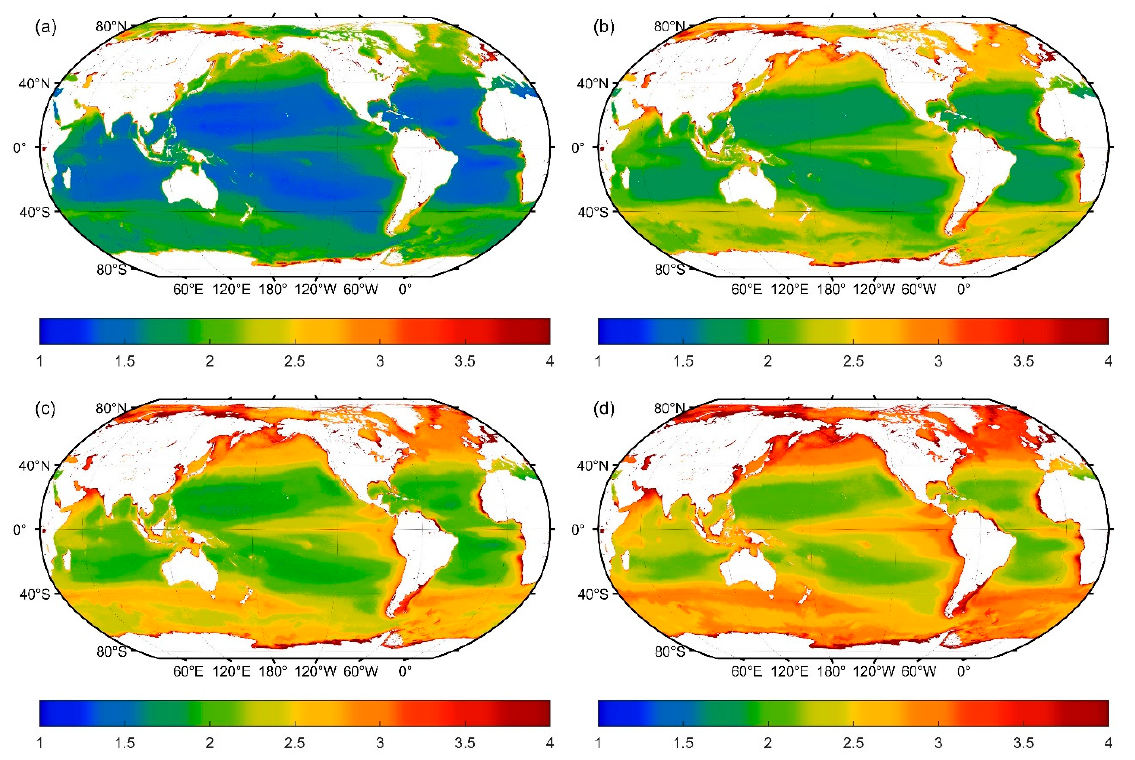
Figure 14. Global distribution of the number of optical depths at 490 nm to reach the corresponding maximum detectable depths with different relative measurement errors including ( a ) 30%, ( b ) 50%, ( c ) 70%, and ( d ) 100%.